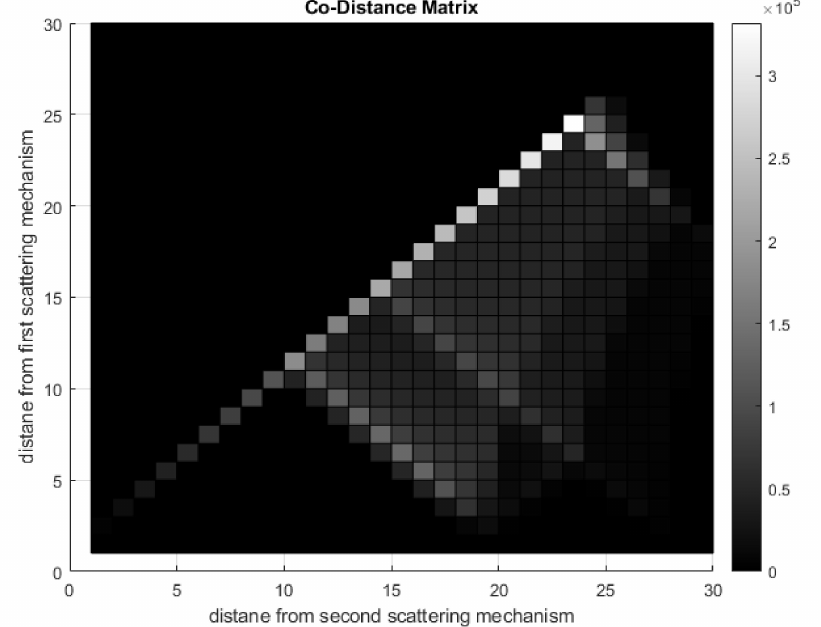
Figure 3. Representation of the Co-Distance Matrix depicting the distances of the scattering mech- anism under examination from the first and second closest scattering mechanisms according to the Cameron methodology. The distances on x and y axes are given in degrees as expressed by Equation (21). The intensity represents the percentage of pixels in the specific distances coordinate. The co-distance matrix depicts the metric distances, computed based on the Equa- tion (23), from the two nearest scattering mechanisms. The X-values correspond to the distance from the second nearest scattering mechanism and the Y-values correspond to the distance from the first nearest scatterer. As inferred from the graph, all the points are located at the lower triangle, which means that the distance from the first elemental scatterer is smaller than that from the second one, as expected. However, the most important is that the majority of points are located across the diagonal. The meaning of this observation is that when the algorithm highlights the dominant elementary scattering mechanism for each resolution cell, its distance difference from the second option is generally small, and the classification can be considered